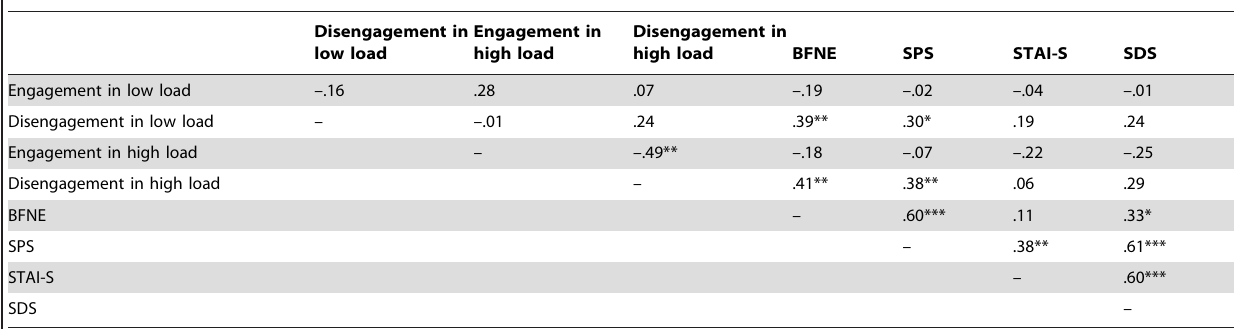
Table 2. Correlations between Attentional Indices and Scales.